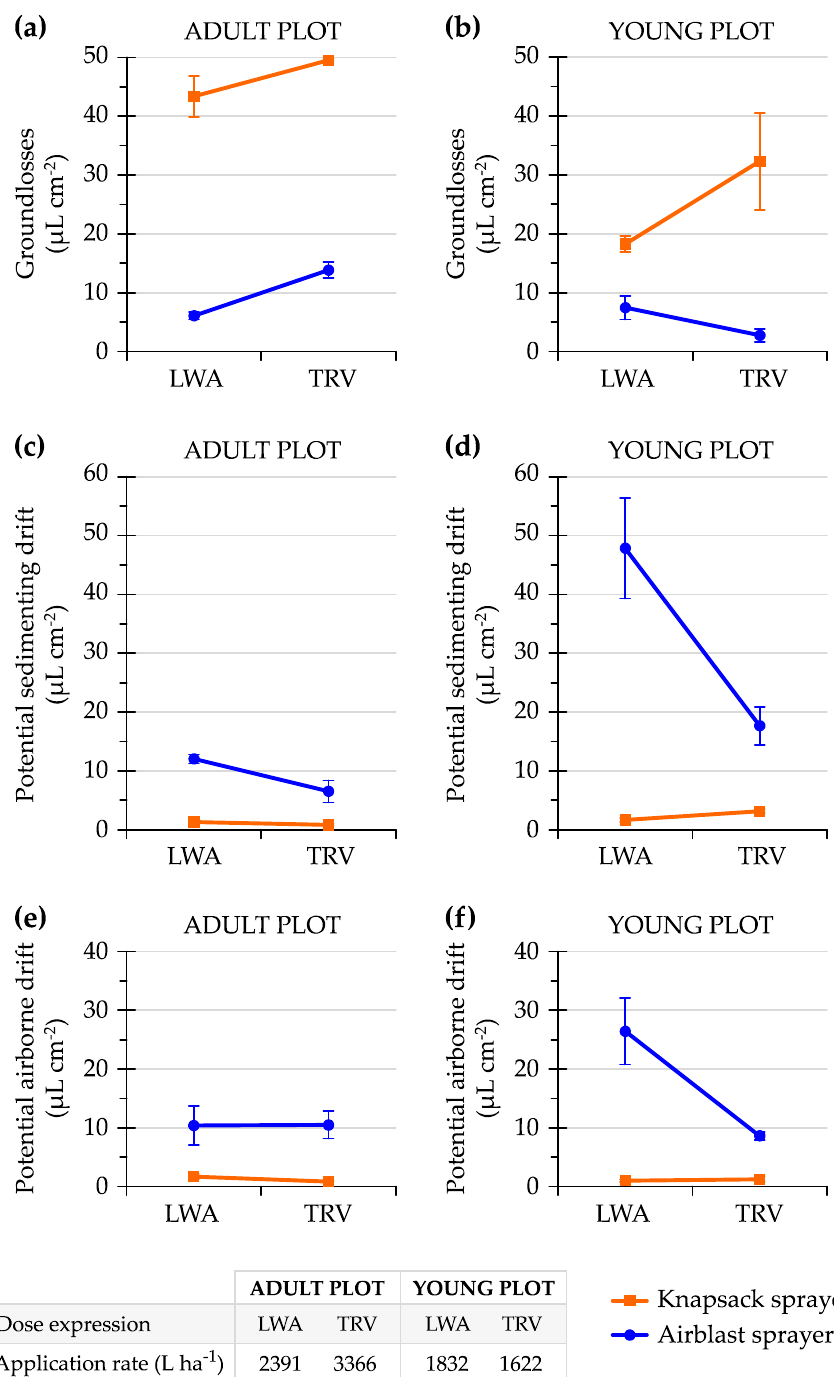
Figure 13. “Sprayer × Dose Expression” interaction for off-target losses ( μ L cm − 2 ) (mean (s.e.)): ground losses for the ( a ) adult and ( b ) young plots, potential sedimenting drift for the ( c ) adult and ( d ) young plots, and potential airborne drift for the ( e ) adult and ( f ) young plots.